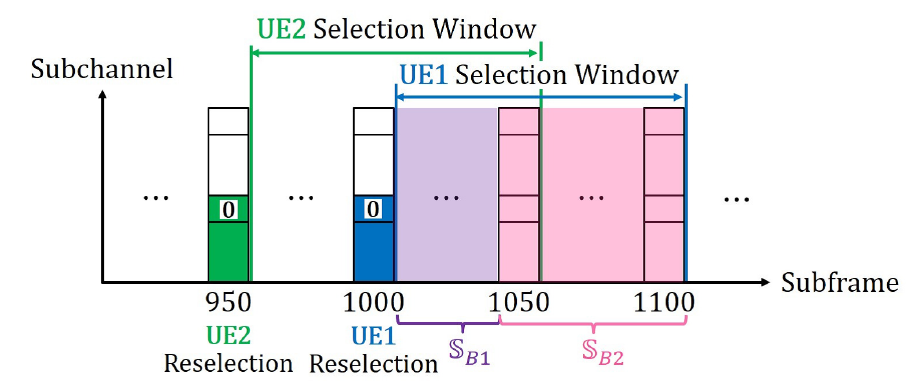
Figure 9. An example of the OA method.